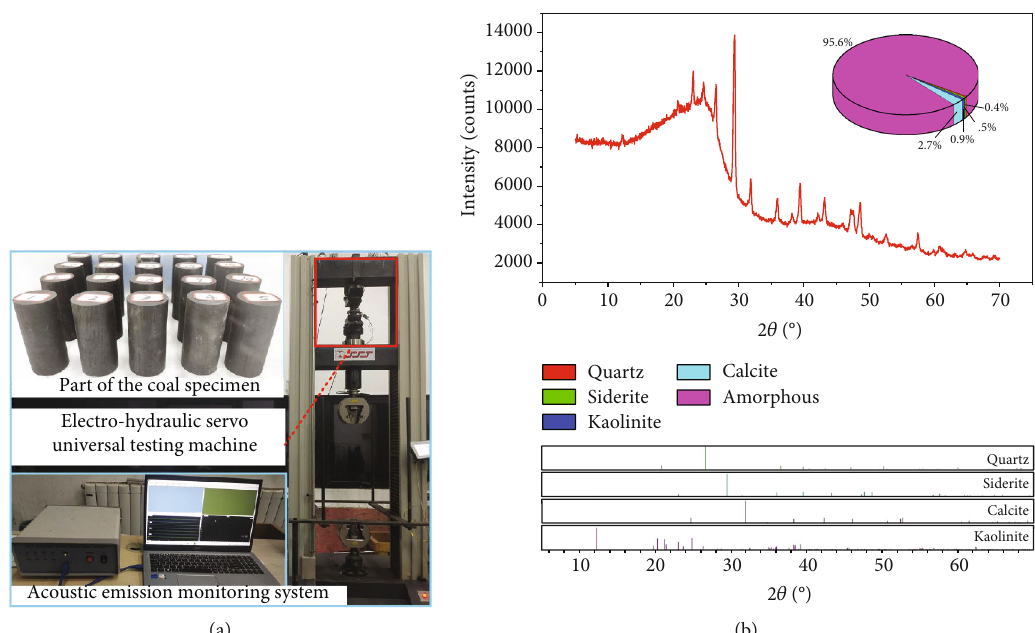
Figure 2: Main test equipment and mineral composition: (a) part of coal specimens and main test equipment and (b) XRD patterns.